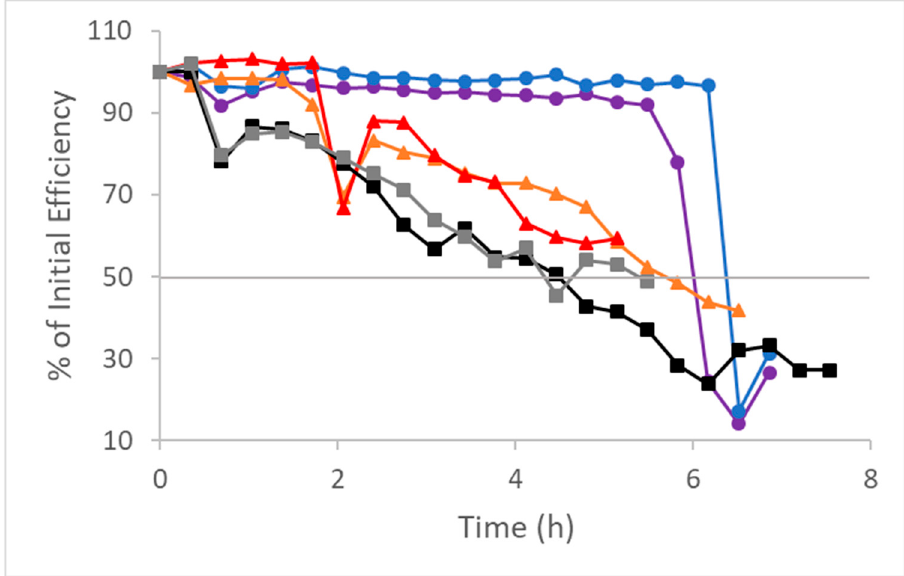
Figure 3. Effect of temperature on the stability of 2.1 × 50 mm 1.6 µm CORTECS HILIC columns, shown as % of initial efficiency vs. time exposed to the basic solution. The columns were exposed to a s w pH 10.37 solution containing acetonitrile and aqueous ammonium bicarbonate, with a 60/40 v / v ACN/buffer ratio (blue and purple circles, 30 °C; orange and red triangles, 50 °C; black and gray squares, 70 °C).